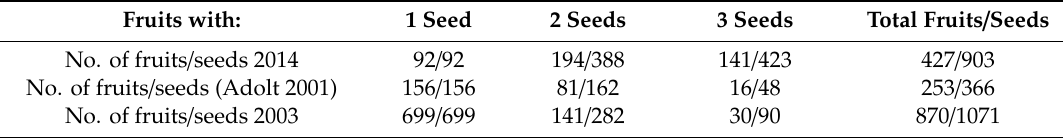
Table 1. Number of fruits with one, two, and three seeds in one panicle. Fruits with: 1